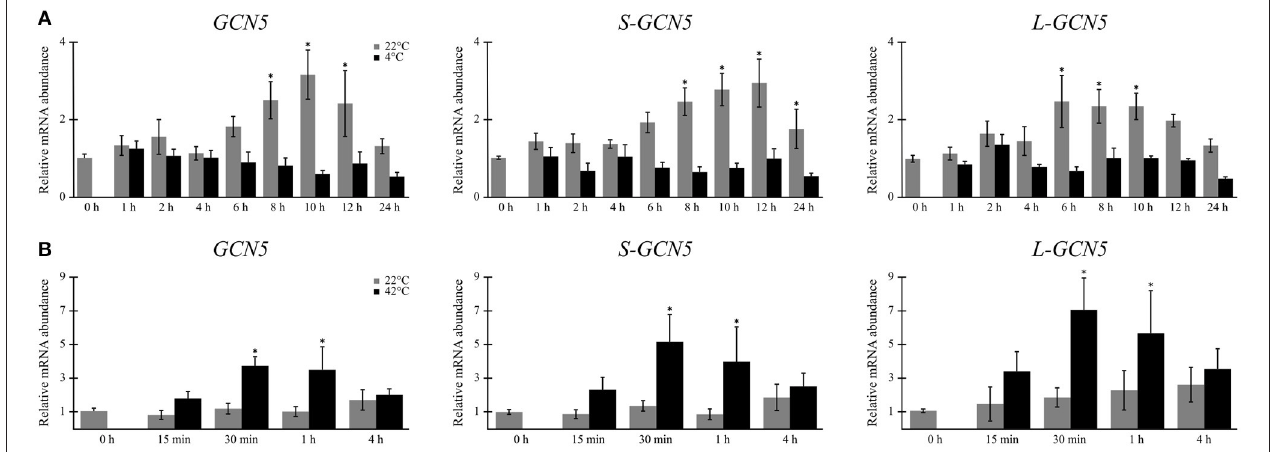
FIGURE 3 | BdGCN5 alternative transcripts are differentially expressed following exposure to temperature extremes. Relative expression profiles of each BdGCN5 alternative transcript in aerial tissues following exposure to: (A) cold (4 ◦ C) or (B) heat (42 ◦ C) for the indicated amounts of time. Error bars represent the standard deviation of at least three biological replicates. An asterisk indicates a statistically significant difference ( P <